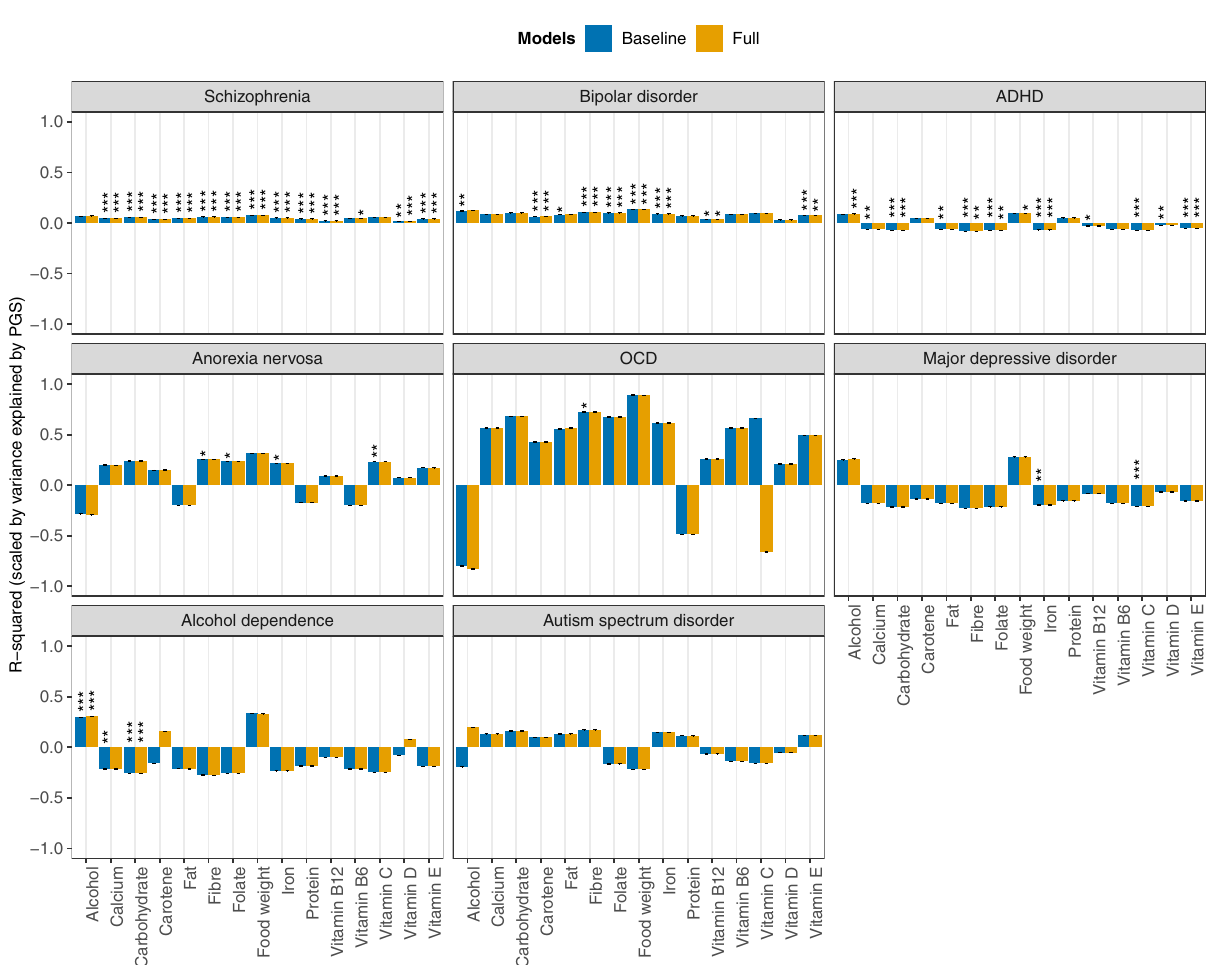
Fig. 1 Associations between polygenic scores for psychiatric disorders and nutrient intake. Results are shown from linear mixed-effects model analyses. Y- axis shows the R 2 estimates which have been scaled by the variance explained by the polygenic score predicting itself on the liability scale and have been multiplied by the direction of the coef fi cient estimate. Colours represent the different models: grey for Model 0 (i.e., baseline model) and yellow for Model 5 (i.e., full model) in con fi guration 1. Error bars represent standard errors and asterisks indicate statistically signi fi cant estimates. Bonferroni-corrected p- value thresholds: ∗ = p < 0.05/132, ∗∗ = p < 0.01/132, ∗∗∗ = p < 0.001/132. Data are represented for 163,619 participants of the UK Biobank cohort. The full results can be found in Supplementary Figs. 3 and